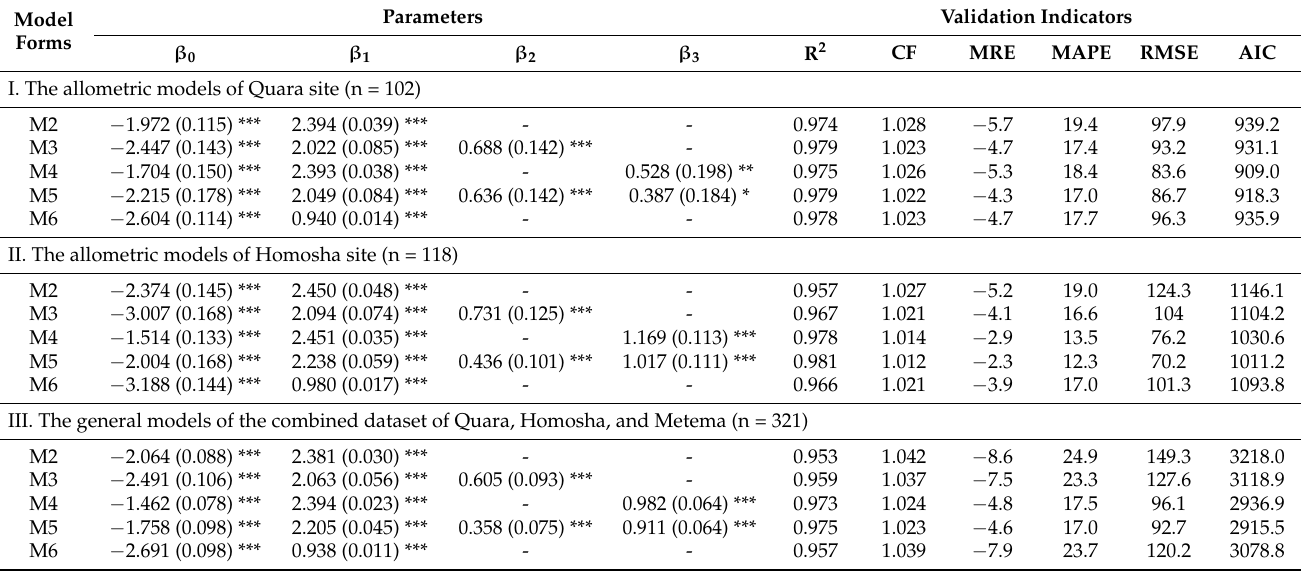
Table 2. The parameters, correction factors, and validation indicators of mixed-species models for CTW. The values in the parentheses refer to the standard errors of model